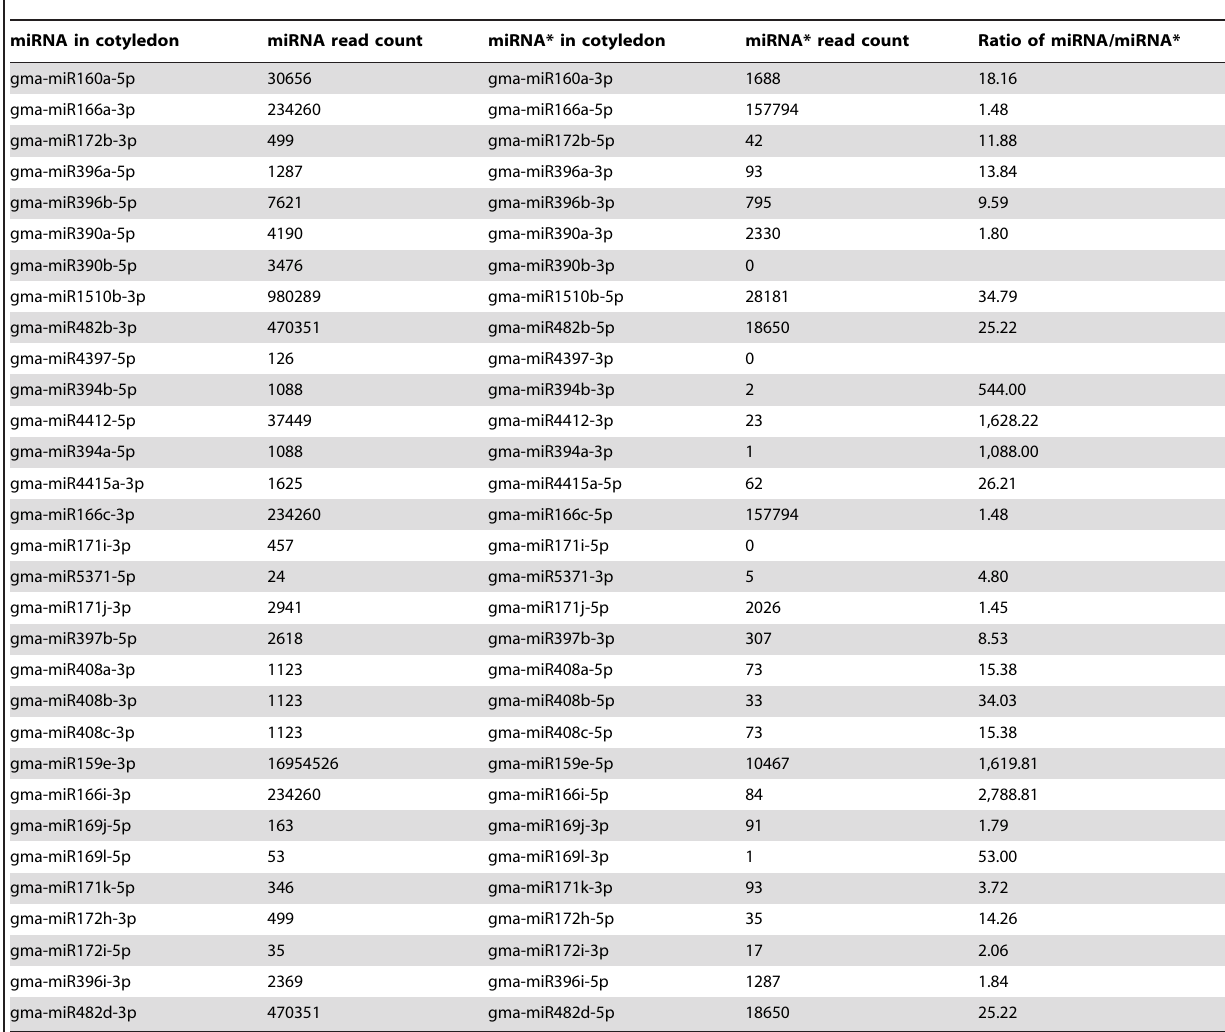
Table 2. Ratio of miRNA and miRNA* for MIRs with Both miRNA-3P and 5P.